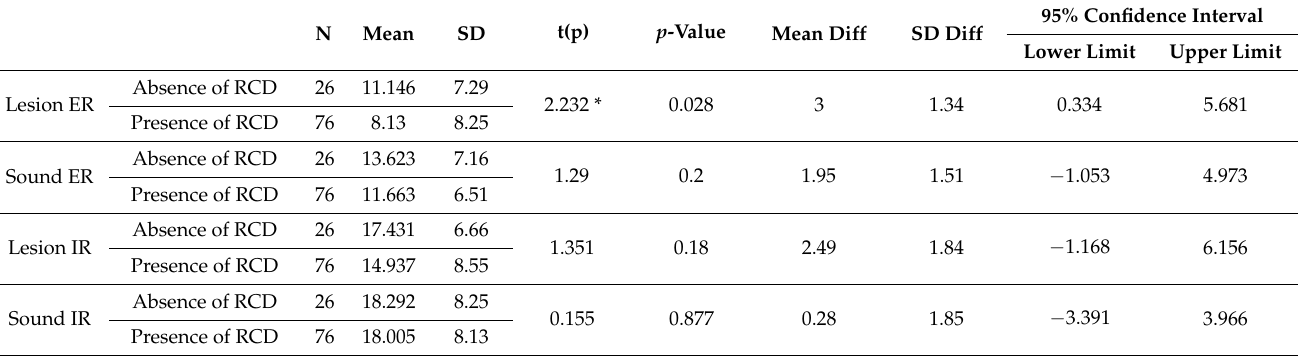
Table 6. T-test of isokinetic strengthening of the ER and IR at both sound and lesion sides and presence of